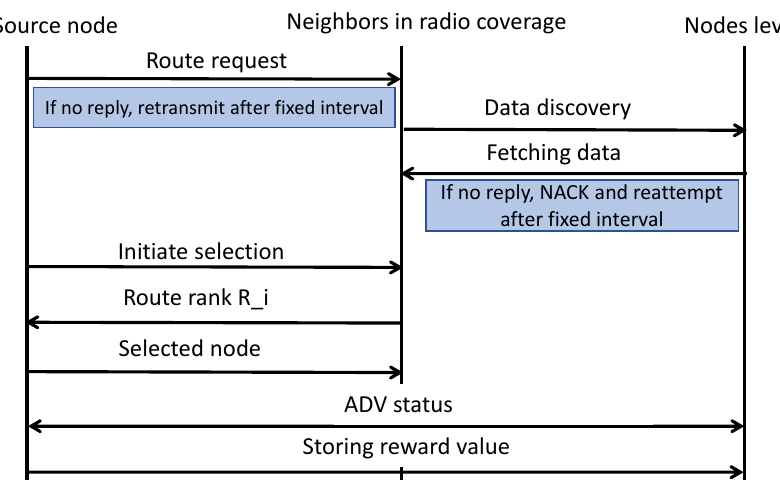
Table 2. Node level information.